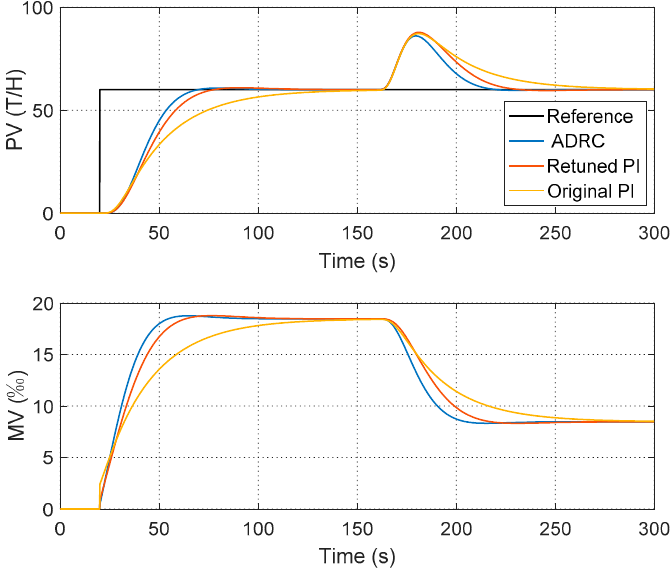
Figure 8. Comparative simulations based on the identified model. Table 2. Controller parameter settings, performance, and robustness indices for the total air control. Method